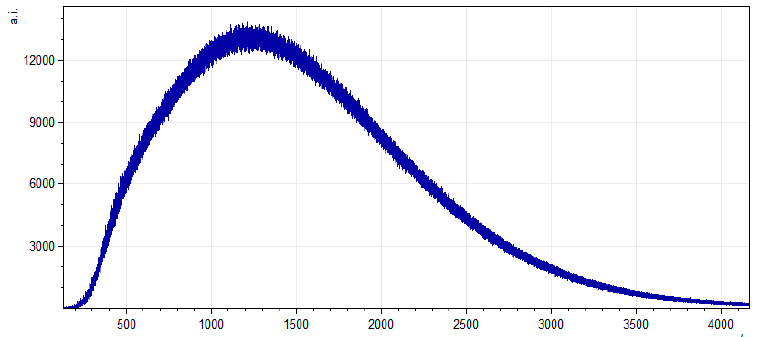
Figure 1. Molecular weight distribution of combined CTP material using laser desorption/ionization-time of flight mass spectroscopy (LDI-TOF-MS). The spectrum was acquired using a total of 2000 shots at 90% laser power.